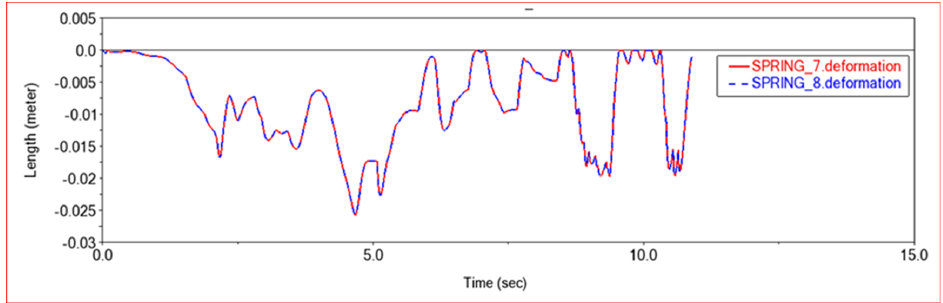
Figure 13. Deformation diagram of rear frame shock absorber in Experiment 1. SPRING-7-Rear frame left shock absorber; SPRING-8-Rear frame right shock absorber.